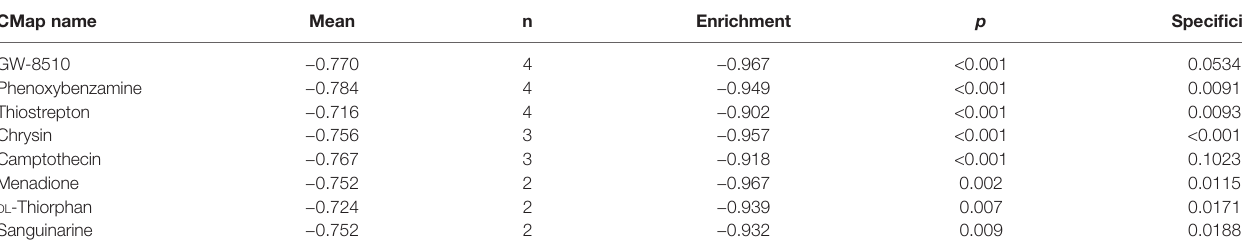
TABLE 3 | Results of CMap